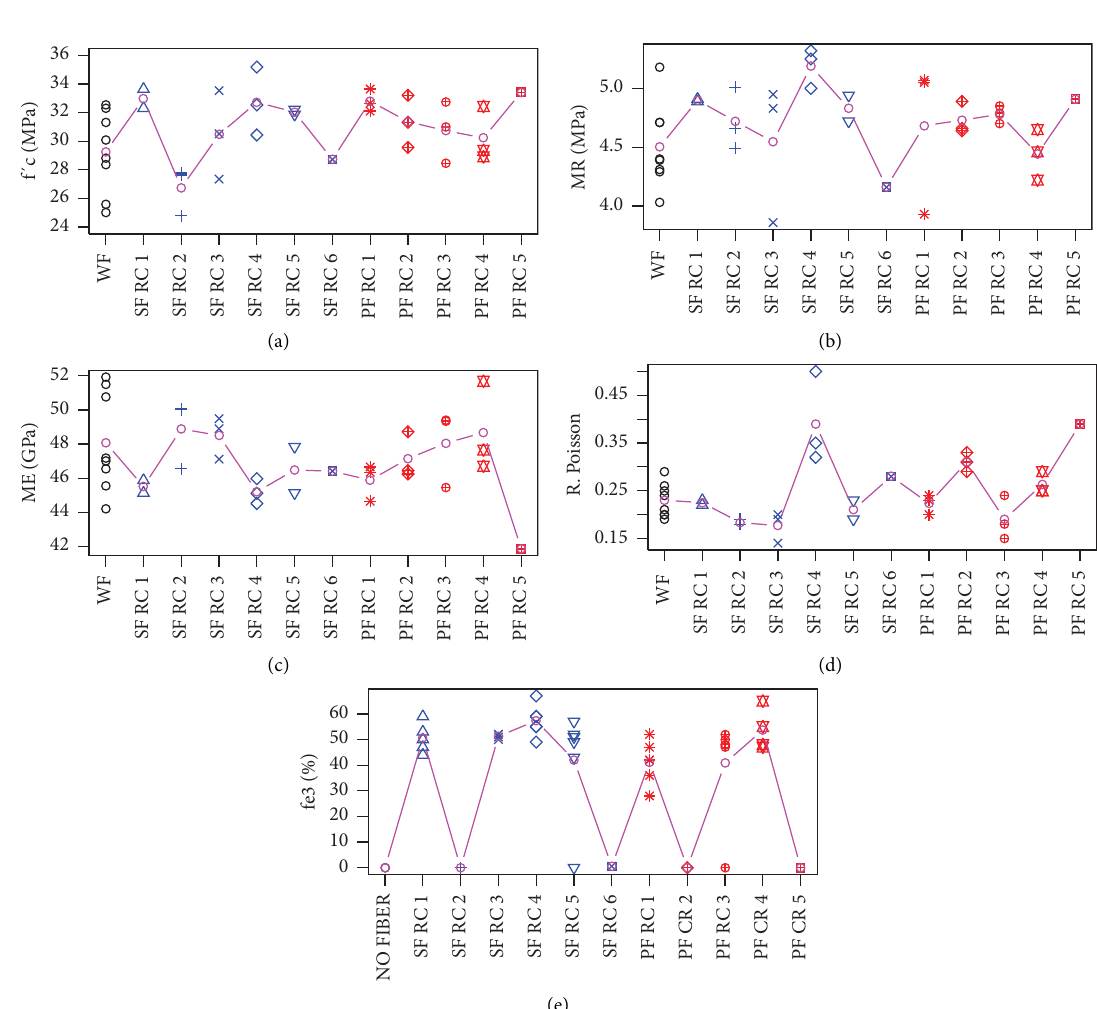
Figure 5: Field mounting for slab deformation.